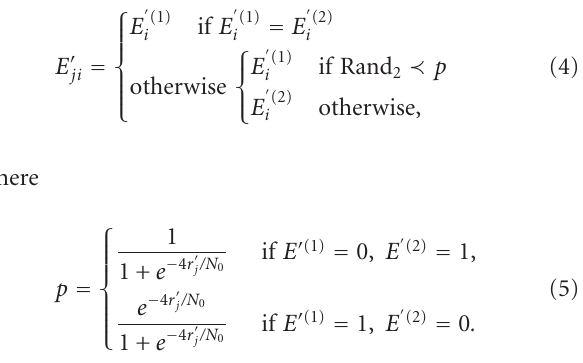
Algorithm DDGA has a time complexity of O ( N i N